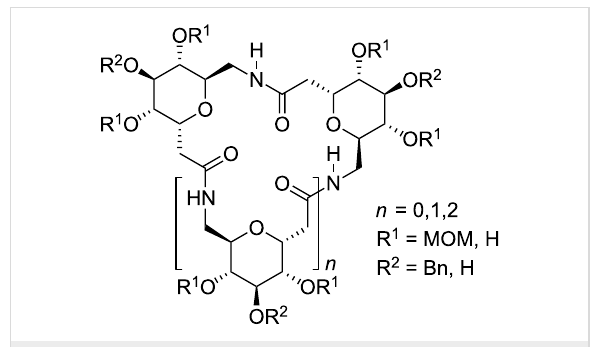
Figure 11: Cyclic homo-oligomers containing